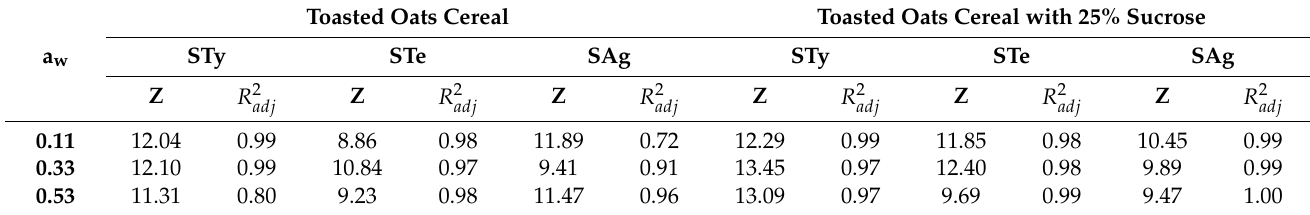
Table 4. Change in temperature needed to obtain a 90% reduction in δ -values (Z-value, ◦ C) for the first log reduction of Salmonella in toasted oats cereal (TOC), as affected by water activity (a w ) and sucrose